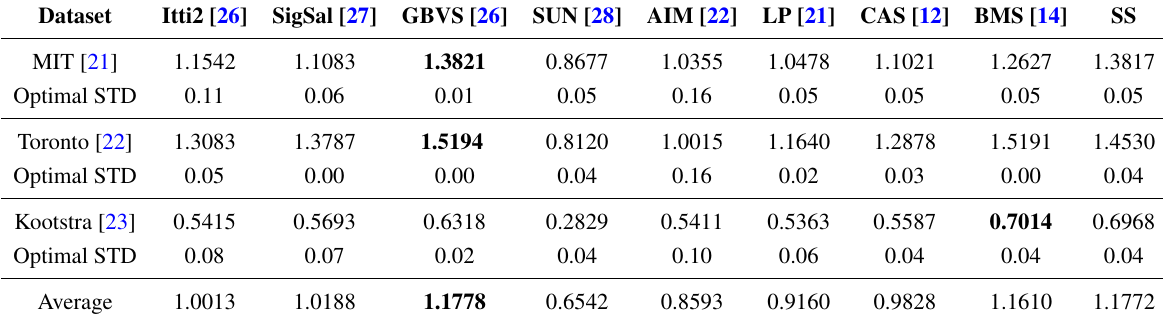
Table 2. Average normalized scanpath saliency (NSS) score with optimal blurring. The highest score on each dataset is shown in bold. The second and third highest are underlined. Dataset